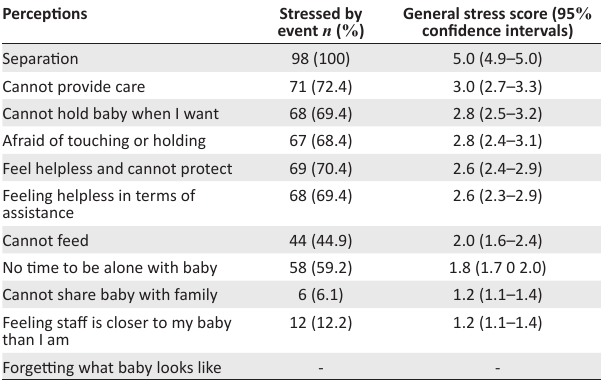
TABLE 3: Parents’ perceptions of parental role adjustment stress ( n = 98). Perceptions